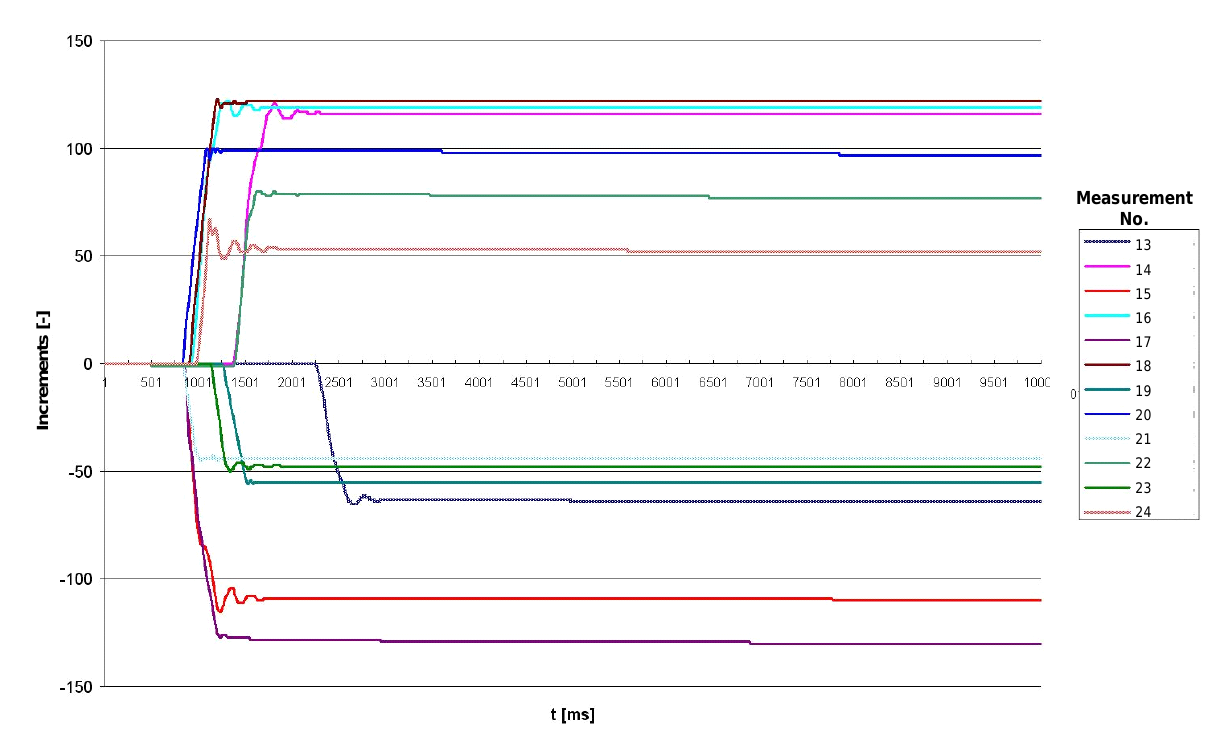
Figure 8. The actuator responses measured at small step changes of the input pressure .